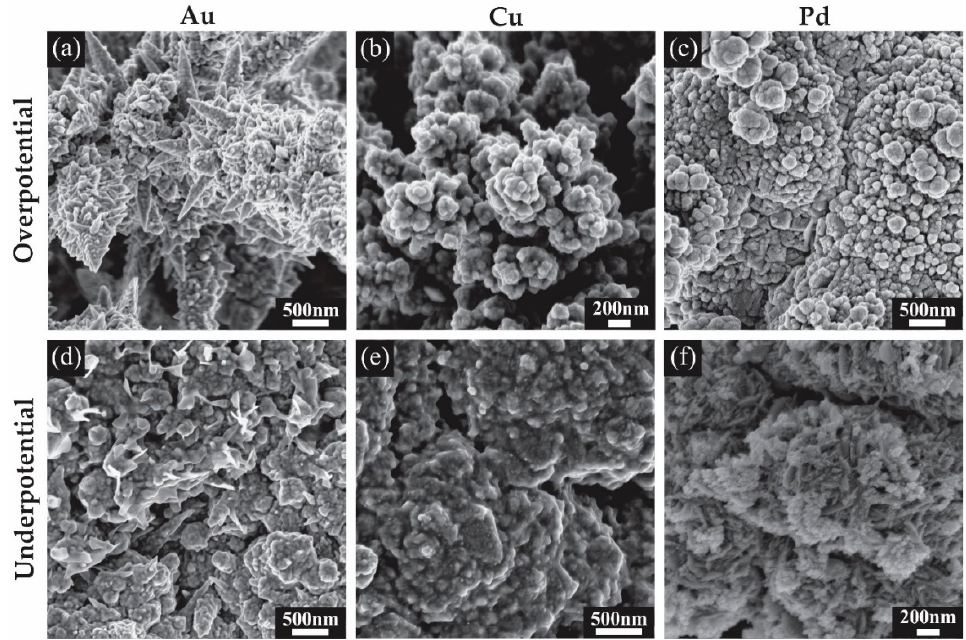
Figure 5. Scanning electron microscopy (SEM) images showing the surface detail on the electrodeposited nanostructures. Deposition parameters: ( a ) Au at 0.1 V, ( b ) Cu at − 0.4 V, ( c ) Pd at 0.1 V, ( d ) Au at 0.5 V, ( e ) Cu at − 0.2 V, ( f ) Pd at 0.35 V.